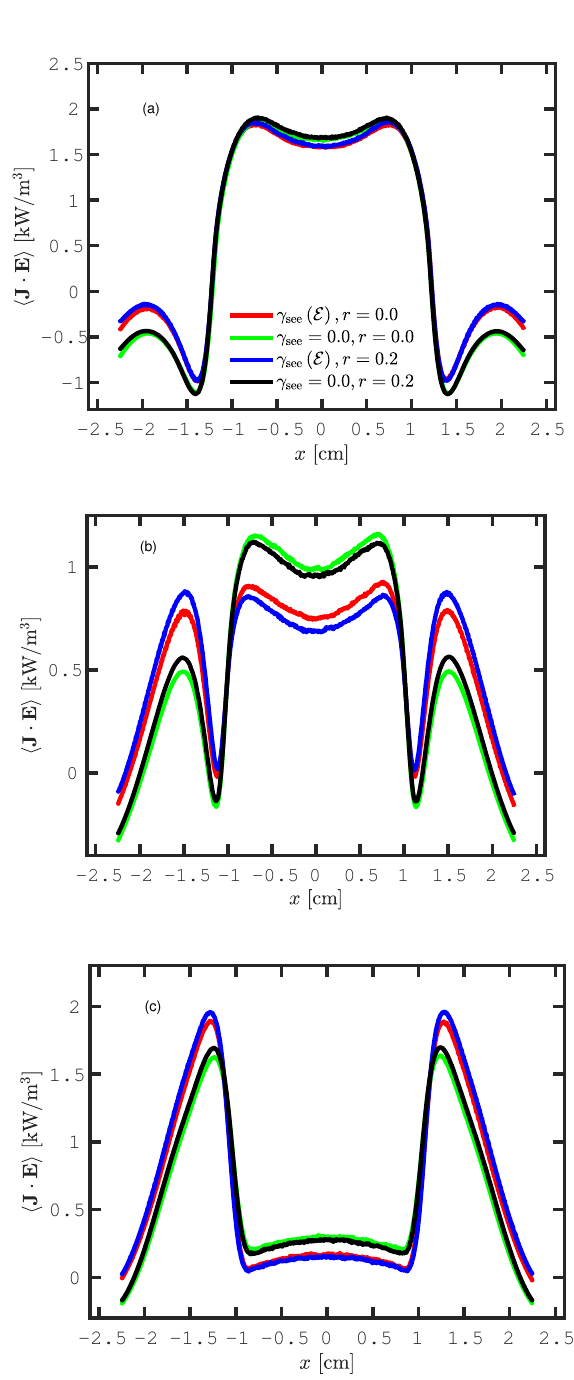
Figure 2. The time averaged electron heating profile for a parallel plate capacitively-coupled oxygen discharge at ( a ) 10 mTorr, ( b ) 25 mTorr, and ( c ) 50 mTorr with a surface quenching coefficient for the singlet metastable molecule O 2 ( a 1 ∆ g ) as γ wqa = 0.0001 and a gap separation of 4.5 cm driven by a 222 V voltage source at a driving frequency of 13.56